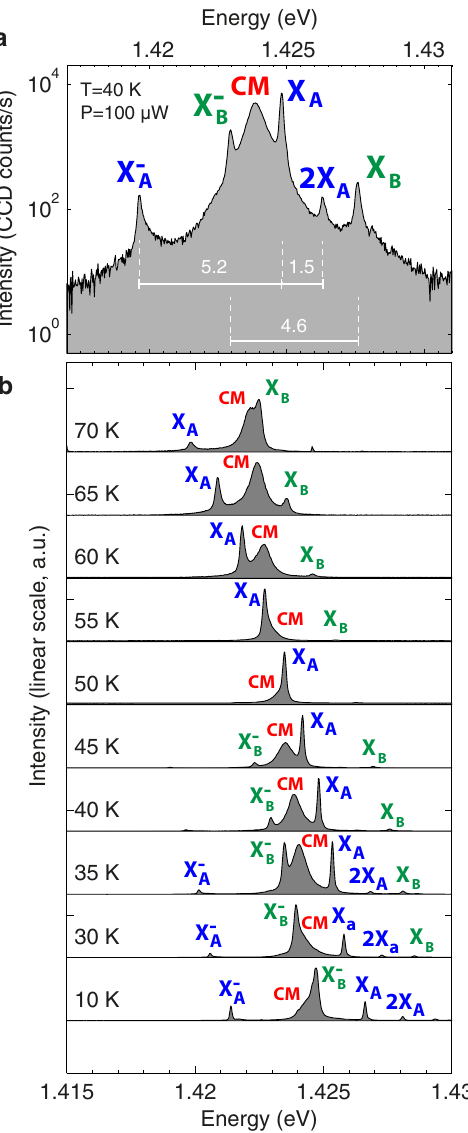
Figure 3. PL spectra of two QDs coupled to the same PhC cavity mode. ( a ) Semi-logarithmic plot showing the cavity mode CM tuned spectrally in between the exciton lines belonging to two spatially separated QDs A and B. Energy separations are indicated in meV. ( b ) Temperature dependence (10–70 K ) of the PL spectra (normalized to maximum